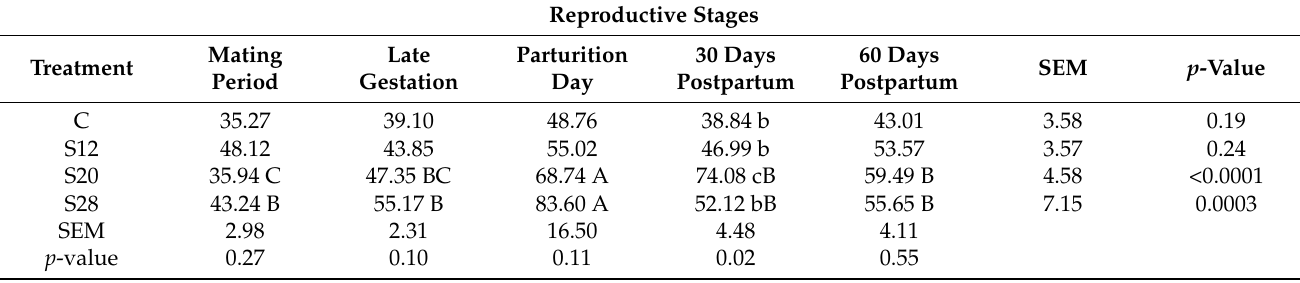
Table 4. The effects of different levels of sunflower hulls in total mixed ration on Awassi ewe’s glucose level (mg/dL) during different reproductive